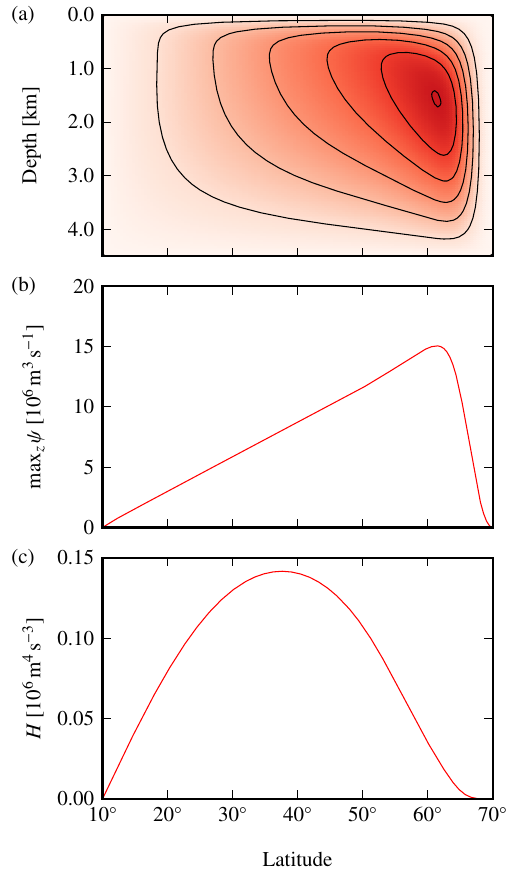
Fig. 4. The standard solution’s (a) overturning stream function ψ (contour interval 2 . 5 × 10 6 m 3 s − 1 ), (b) its vertical maximum max z ψ , and (c) its advective meridional buoyancy transport H .